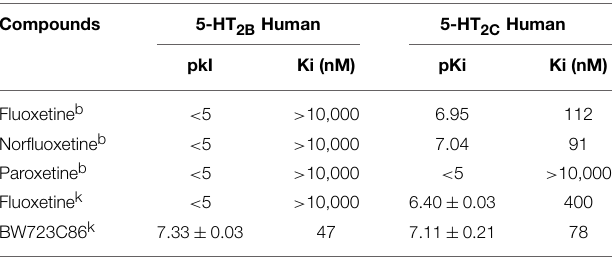
TABLE 1 | Affinity constants (pKi) for different binding compounds to Human 5-HT 2C and 5-HT 2B